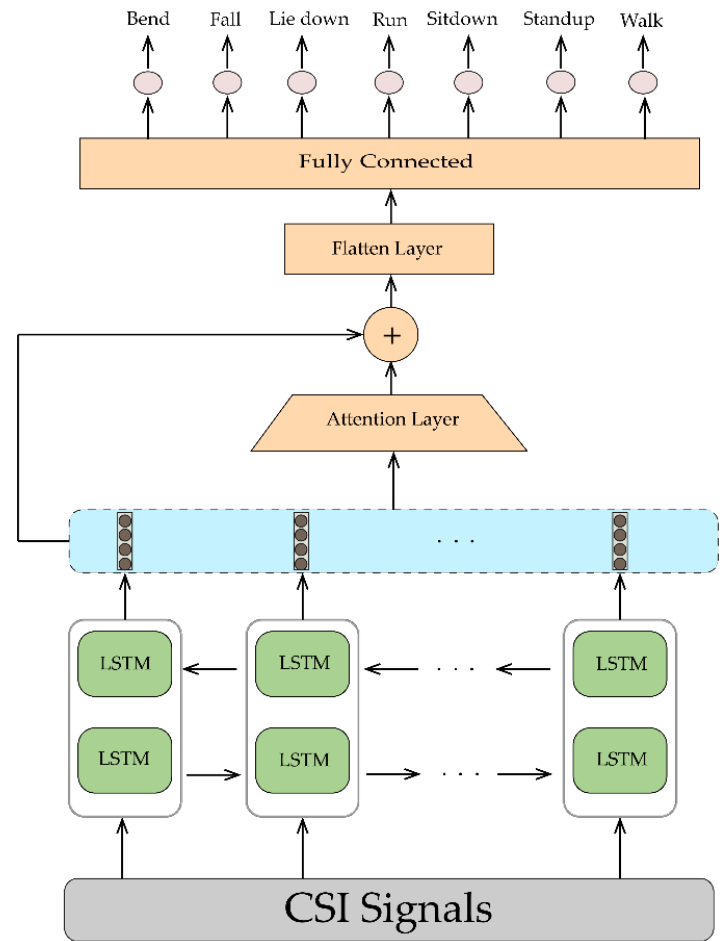
Figure 4. BLSTM structure used in this